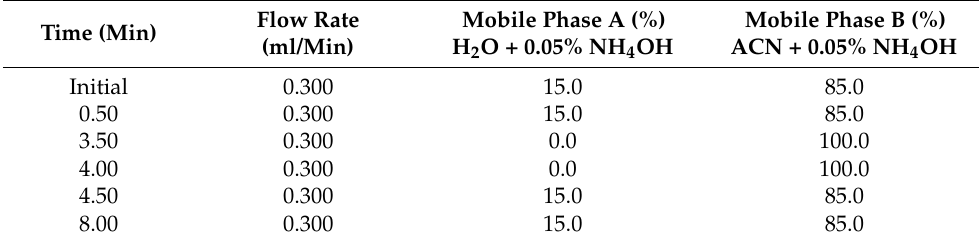
Table 2. Linear gradient applied for NO 2 -FAs separation on RP-UPLC-MS/MS. Time